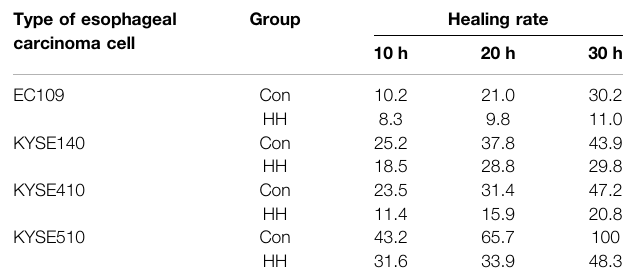
TABLE 9 | Scratch healing rate before and after